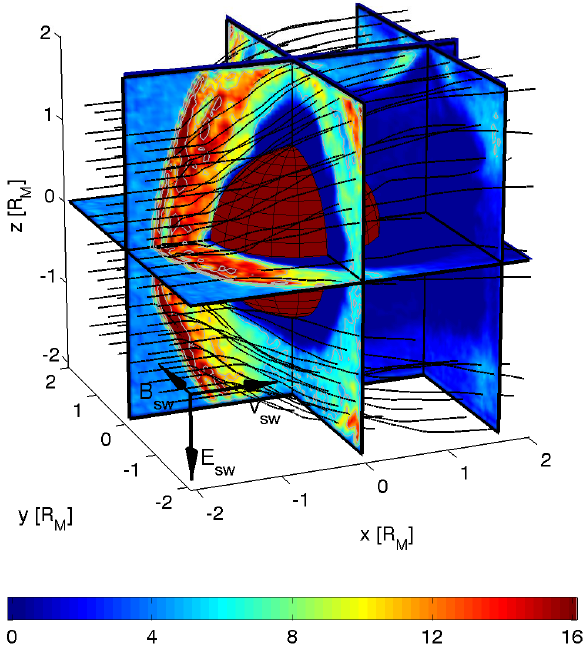
Fig. 7. Simulation results for the “standard run”. The cutting planes show the solar wind density in cm − 3 . The black solid lines repre- sent streamlines of the corresponding velocity field. The solar wind flows almost symmetrically around the obstacle. On the nightside, a plasma wake is formed, where the solar wind density vanishes al- most completely. This wake region, however, is not symmetric with respect to the equatorial plane, as can be seen from the cutting plane at x = 5 / 3 R M . Downstream of the bow shock, a multiple shocklets structure is